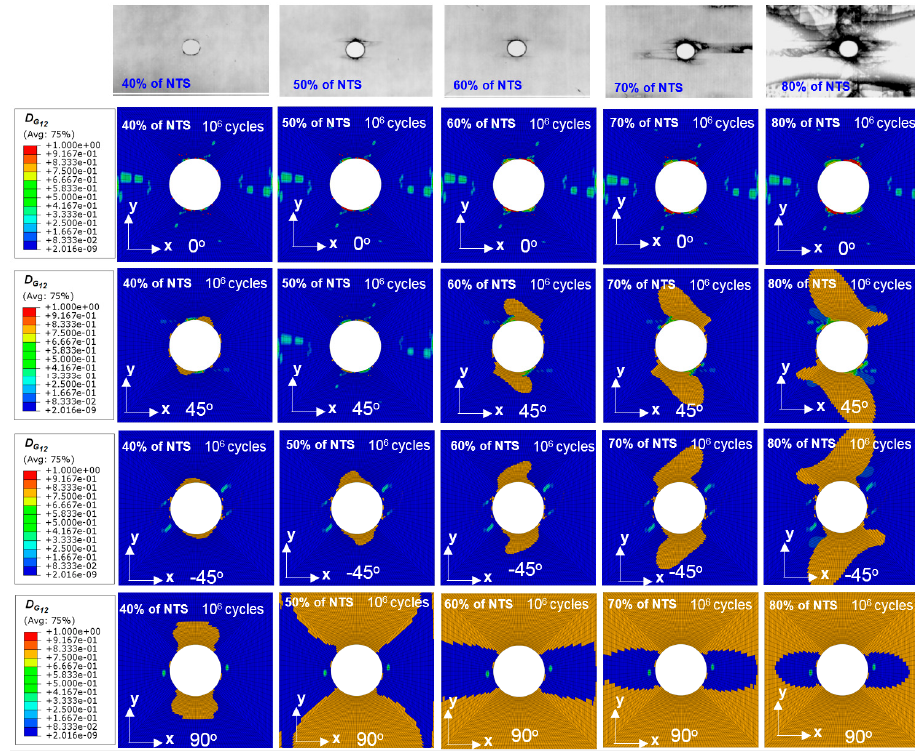
Figure 14. Reduction in stiffness E 2 in each ply of the OHT specimen after 10 6 cycles.